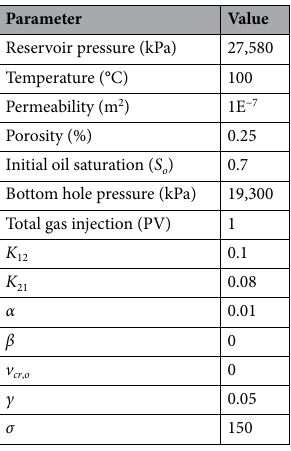
Table 4. Simulation input